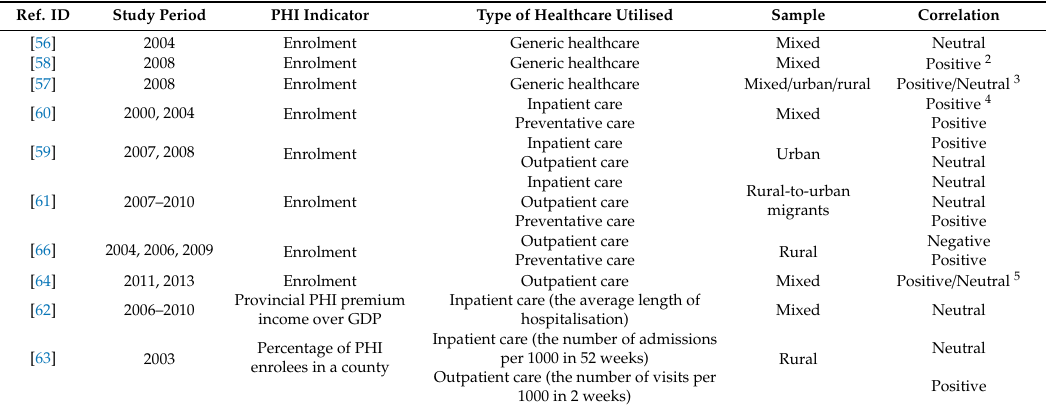
Table 4. The correlation between PHI and access to healthcare 1